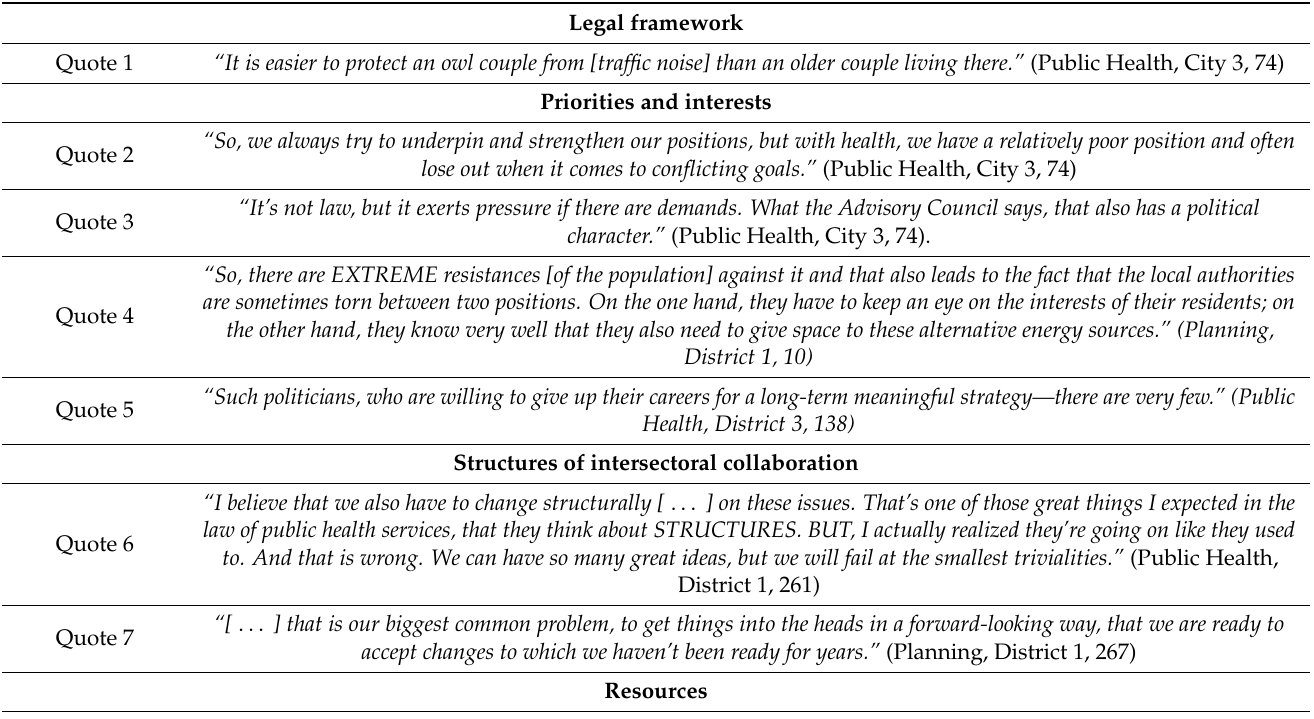
Table 2. Illustrating quotations of interviewees by